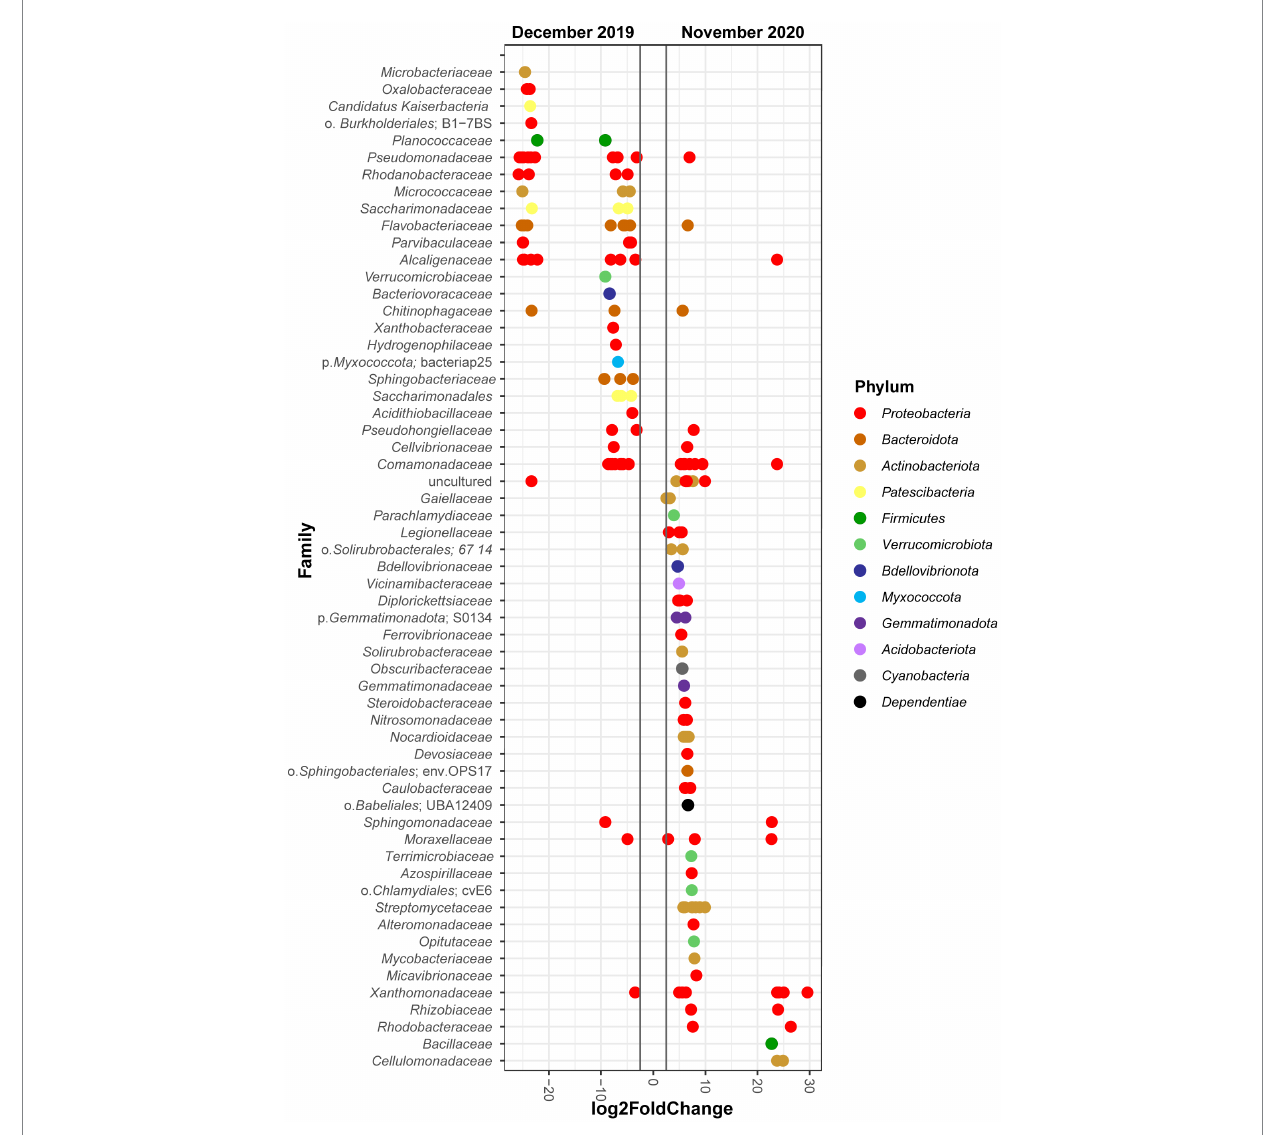
FIGURE 4 Differential abundance analysis of bacterial ASVs. The analysis shows the log2FoldChange of individual ASVs from the different bacterial families that significantly changed comparing the T2 and T5 timepoints (December 2019 and November 2020, respectively, p adjusted value <0.01). Colors according to the phylum to which the represented ASVs and families